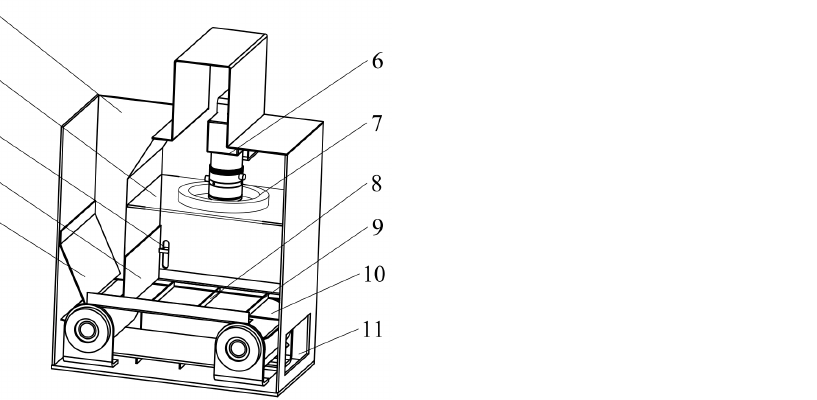
Figure 2. Structure diagram of infusion-type sampling device. (1) Inlet, (2) dust baffle, (3) flow-rate- adjustment lever, (4) deflector, (5) baffle, (6) camera, (7) light source, (8) conveyor belt, (9) corrugation, (10) transparent platen, and (11) outlet.